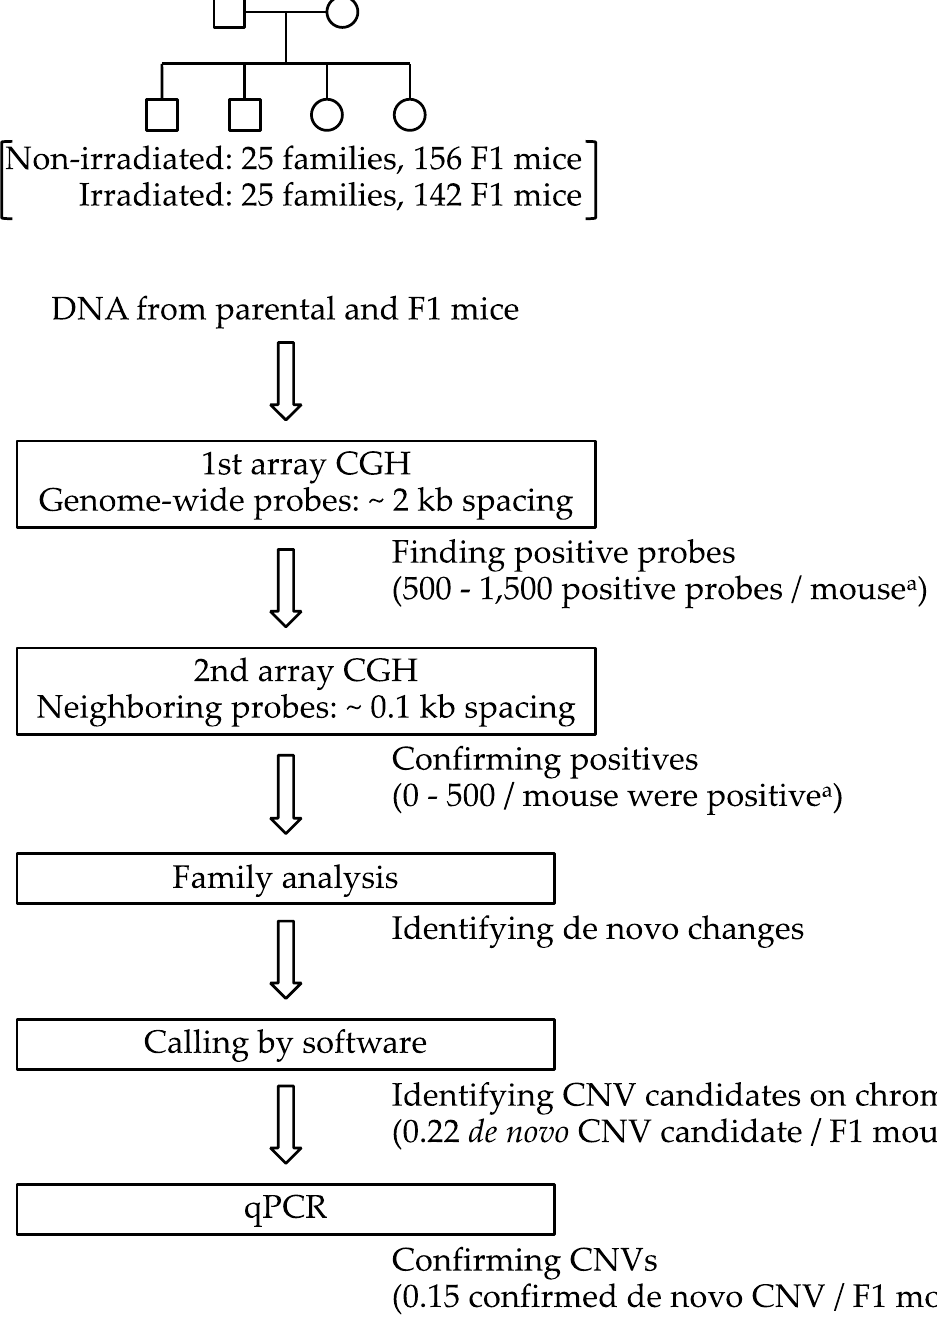
Figure 1. Experimental design for the identification of de novo copy number variations (CNVs). a Approximate numbers of probes for the first array CGH. b F1 mice bearing 4 or more confirmed de novo CNVs are excluded.